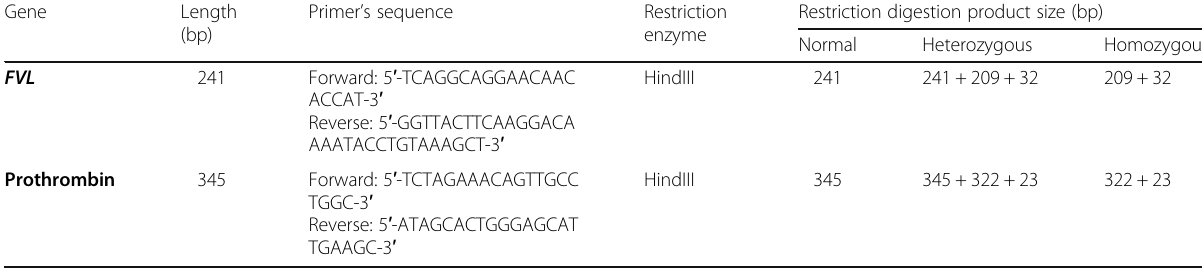
Table 1 Specific primer sequences, restriction enzymes, and restriction digestion products ’ sizes for FVL and prothrombin G20210A . The PCR-RFLP products ’ sizes are given according to the genotype polymorphisms Gene Length Primer ’ s (bp)